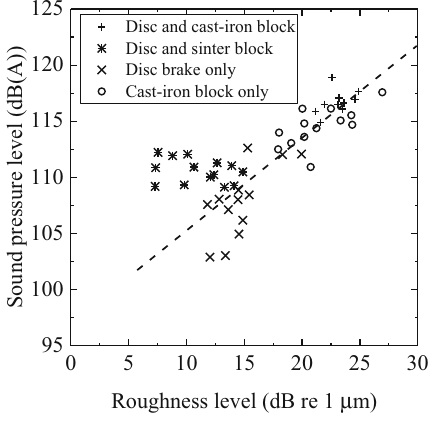
Fig. 11 Sound pressure pass-by level versus wheel roughness